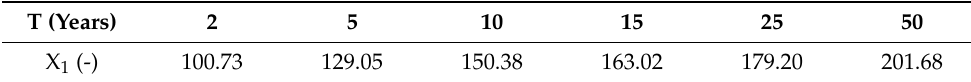
Table 5. Estimated quantiles for X 1 derived from the GEV